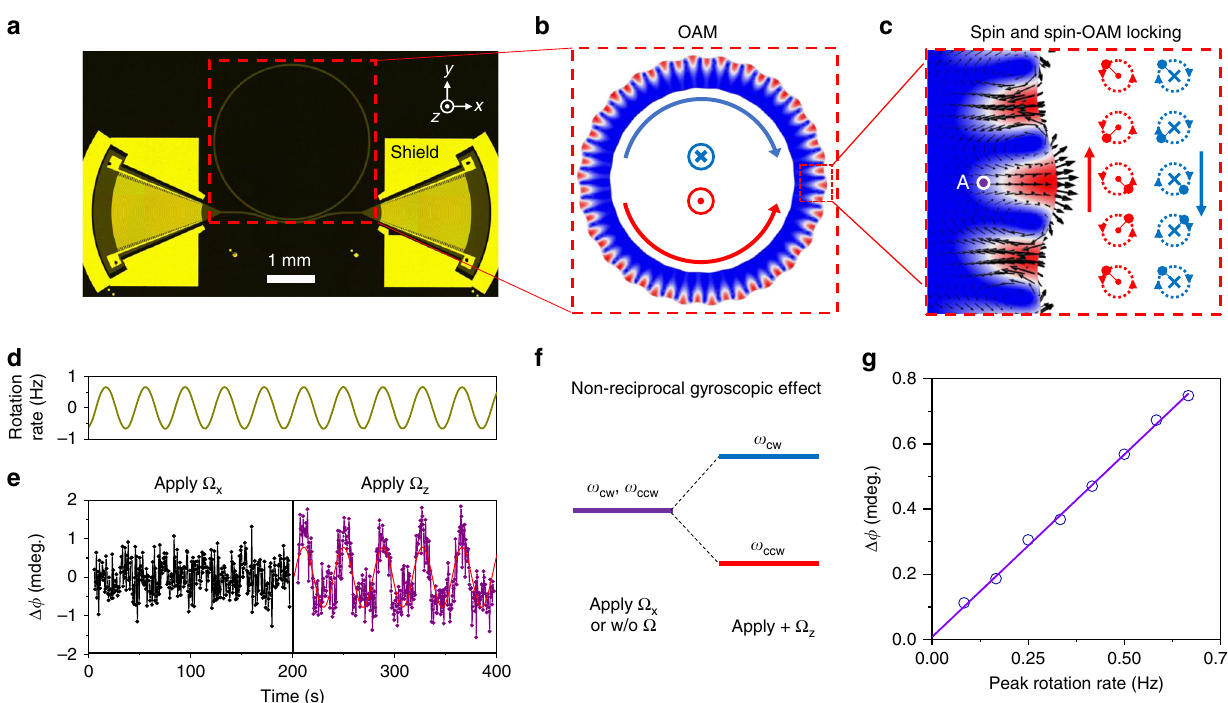
Fig. 4 Phononic spin – orbit interaction in a ring resonator. a Device under test. The pair of IDTs function as the input and output of the circuit and address the clockwise (CW) and counter-clockwise (CCW) love-like mode simultaneously. Focused IDTs and shield structure are used to improve signal to noise ratio. b Orbital angular momentum (OAM) carried by Love-like mode. c Left: Zoomed in mode pro fi le of Love-like mode, with displacements indicated by the black arrows. We observe circular trajectory of displacement. Right: Spin-momentum locking — CW and CCW propagating phonons possess spins of opposite direction. The direction of spin of point A (the purple dot in the left panel) is indicated by either cross (right-hand) or dot (left-hand). Dash line indicates the trajectory of displacement (solid dot). d Phase response difference between CW and CCW modes, when the device is subject to in-plane and out-of-plane rotation. The comparison between Δ ϕ measured with rotation of different direction is a clear signature of SOI. e Applying an out-of-plane CCW rotation to the system, CW and CCW Modes have resonant frequency shift towards the opposite direction, due to the opposite chiralities that they